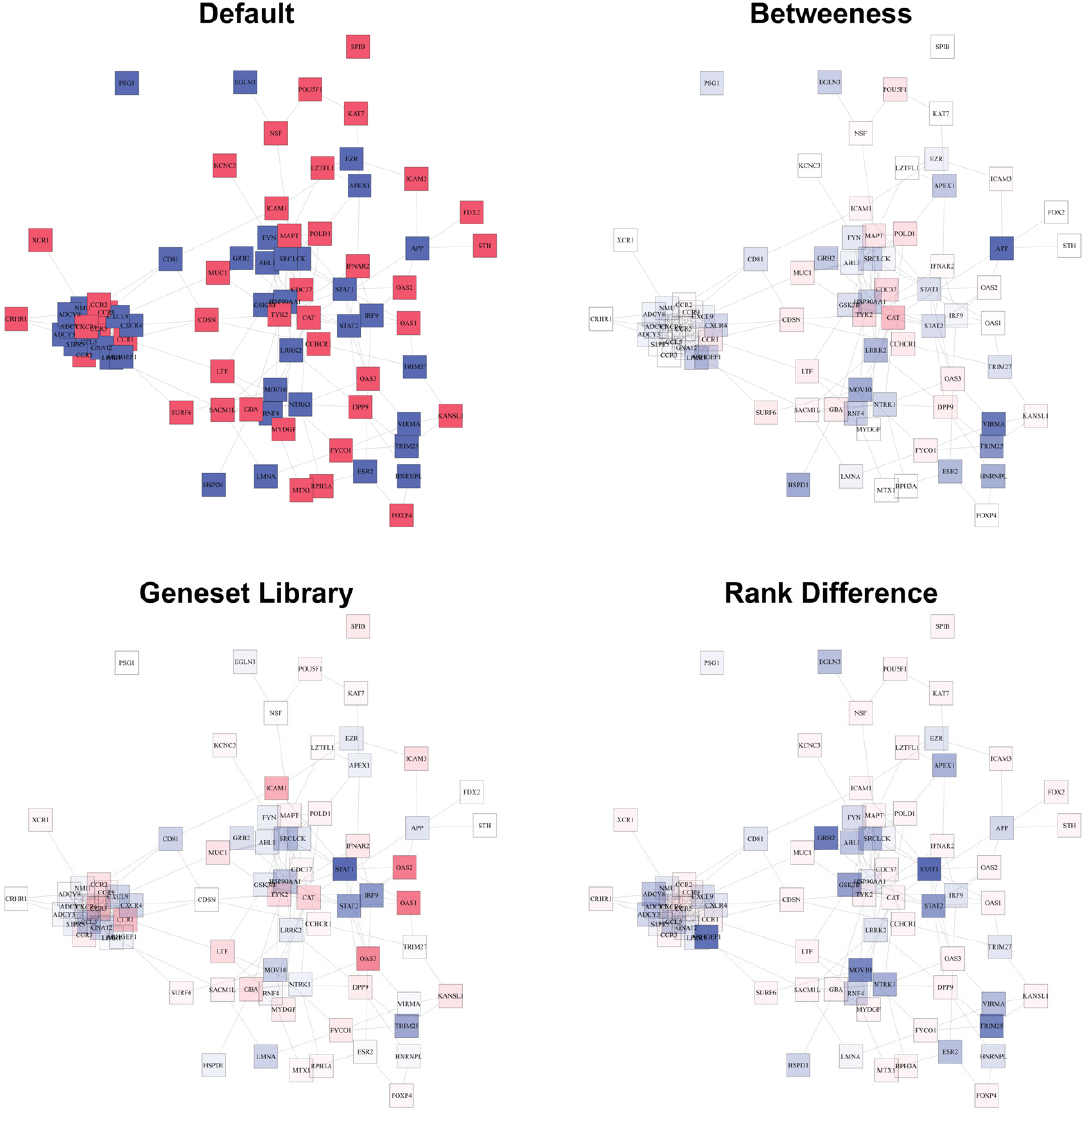
Figure 4. Network visualization of top 100 GWAB-COVID results with B2 of HGI GWAS Release 6. Only genes included in HumanNet are included in this network. Adjacent genes that are visualized in the web server are excluded here for simplification. For the “Default” network graph, the blue nodes are the newly discovered genes that are not GWAS-significant. The red nodes are the GWAS significant genes. For the rest of the network graphs, the nodes have more transparency with lower ranks based on their betweenness centrality, COVID-19 geneset library frequency, and rank changes from GWAS alone to COVID-GWAB.